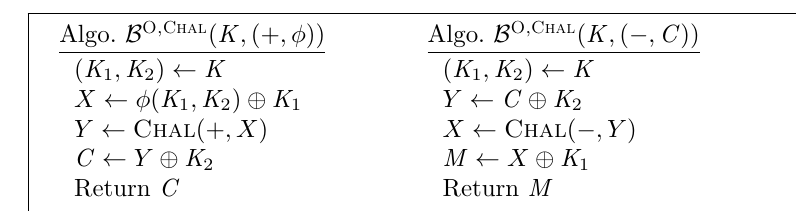
Figure 9: Algorithm B used in the KDM analysis of one-round